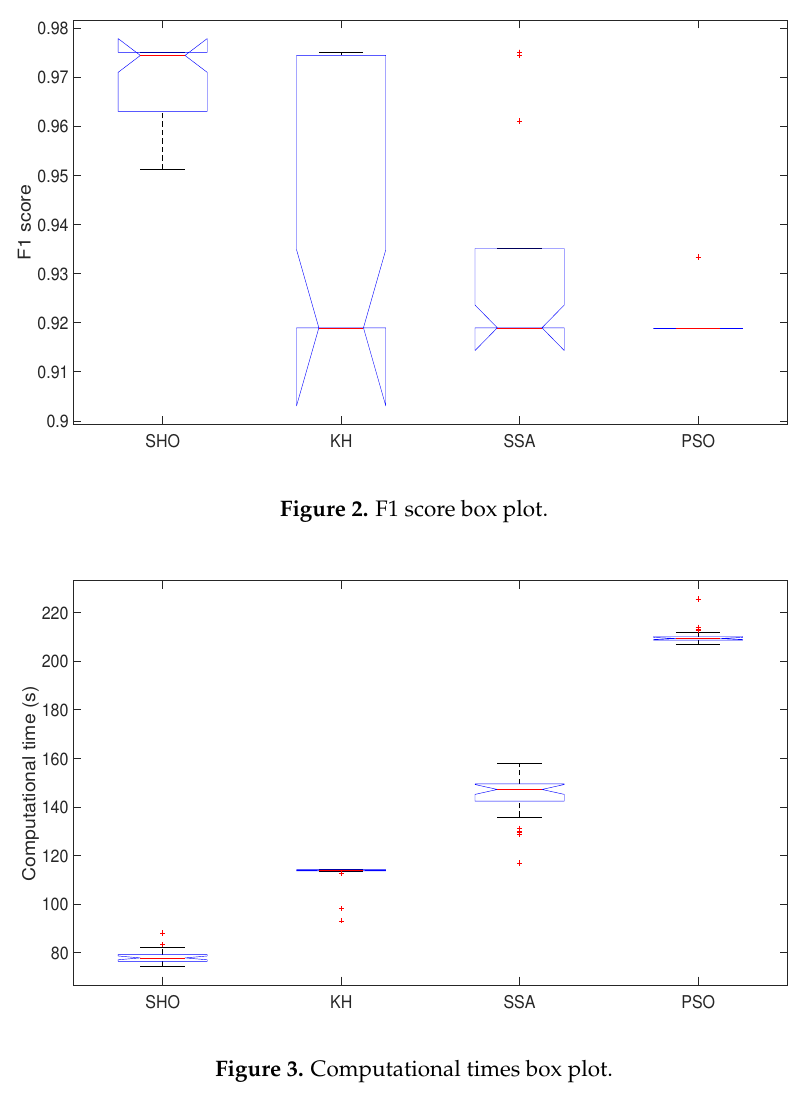
Figure 3. Computational times box plot.